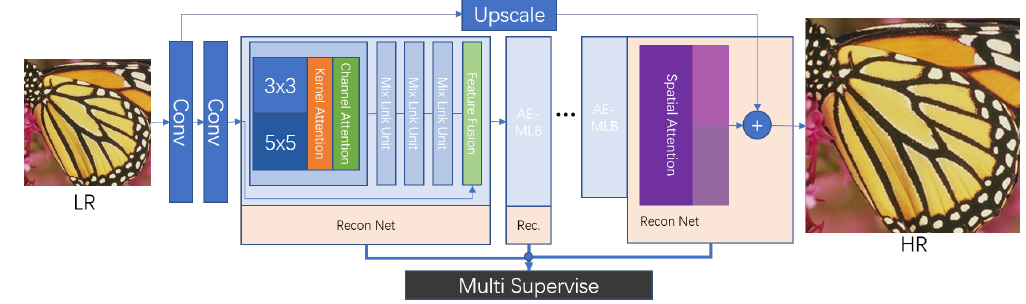
Figure 1. Overall structure of triple-attention mixed-link